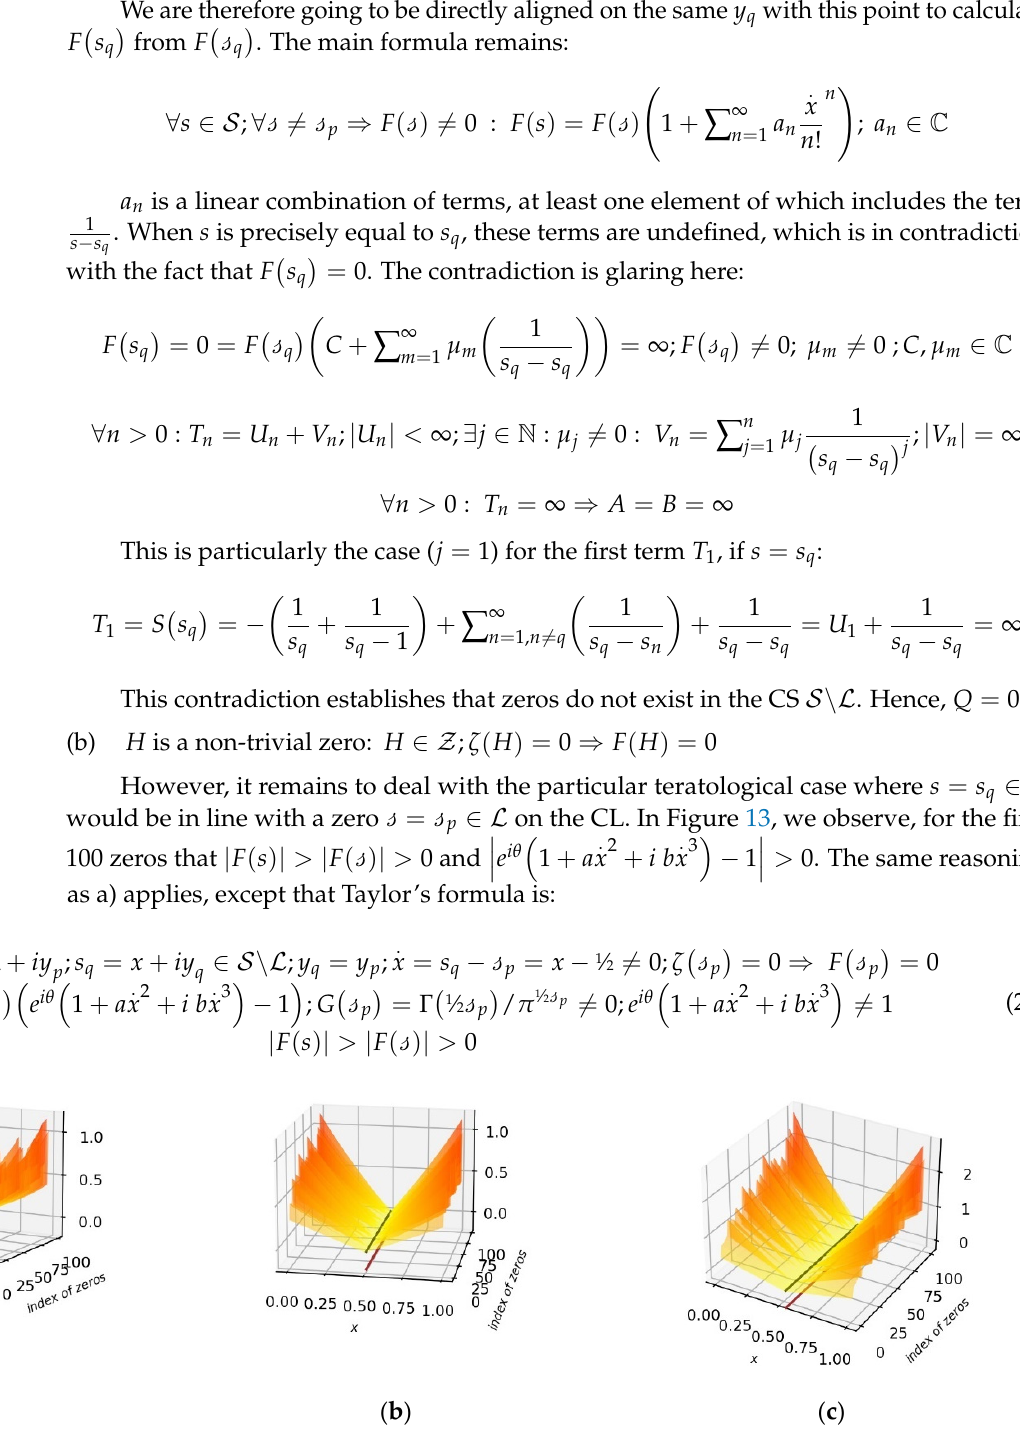
Figure 13. 3D plot ( x , index of ζ zeros ) : On these 3 images, we observe that the modulus of the estimated function F , of the true 𝐹 function and of the exponential and polynomial expression cancel each other out only on the CL, in accordance with the RH, and this for cross-sections with non-trivial zeros. ( a ) estimated |𝐹(s)| ; ( b ) true |𝐹(s)| ; ( c ) (cid:3627)𝑒 (cid:3036)(cid:3087) (1 + 𝑎𝑥(cid:4662) (cid:2870) + 𝑖 𝑏𝑥(cid:4662) (cid:2871) ) − 1(cid:3627) .